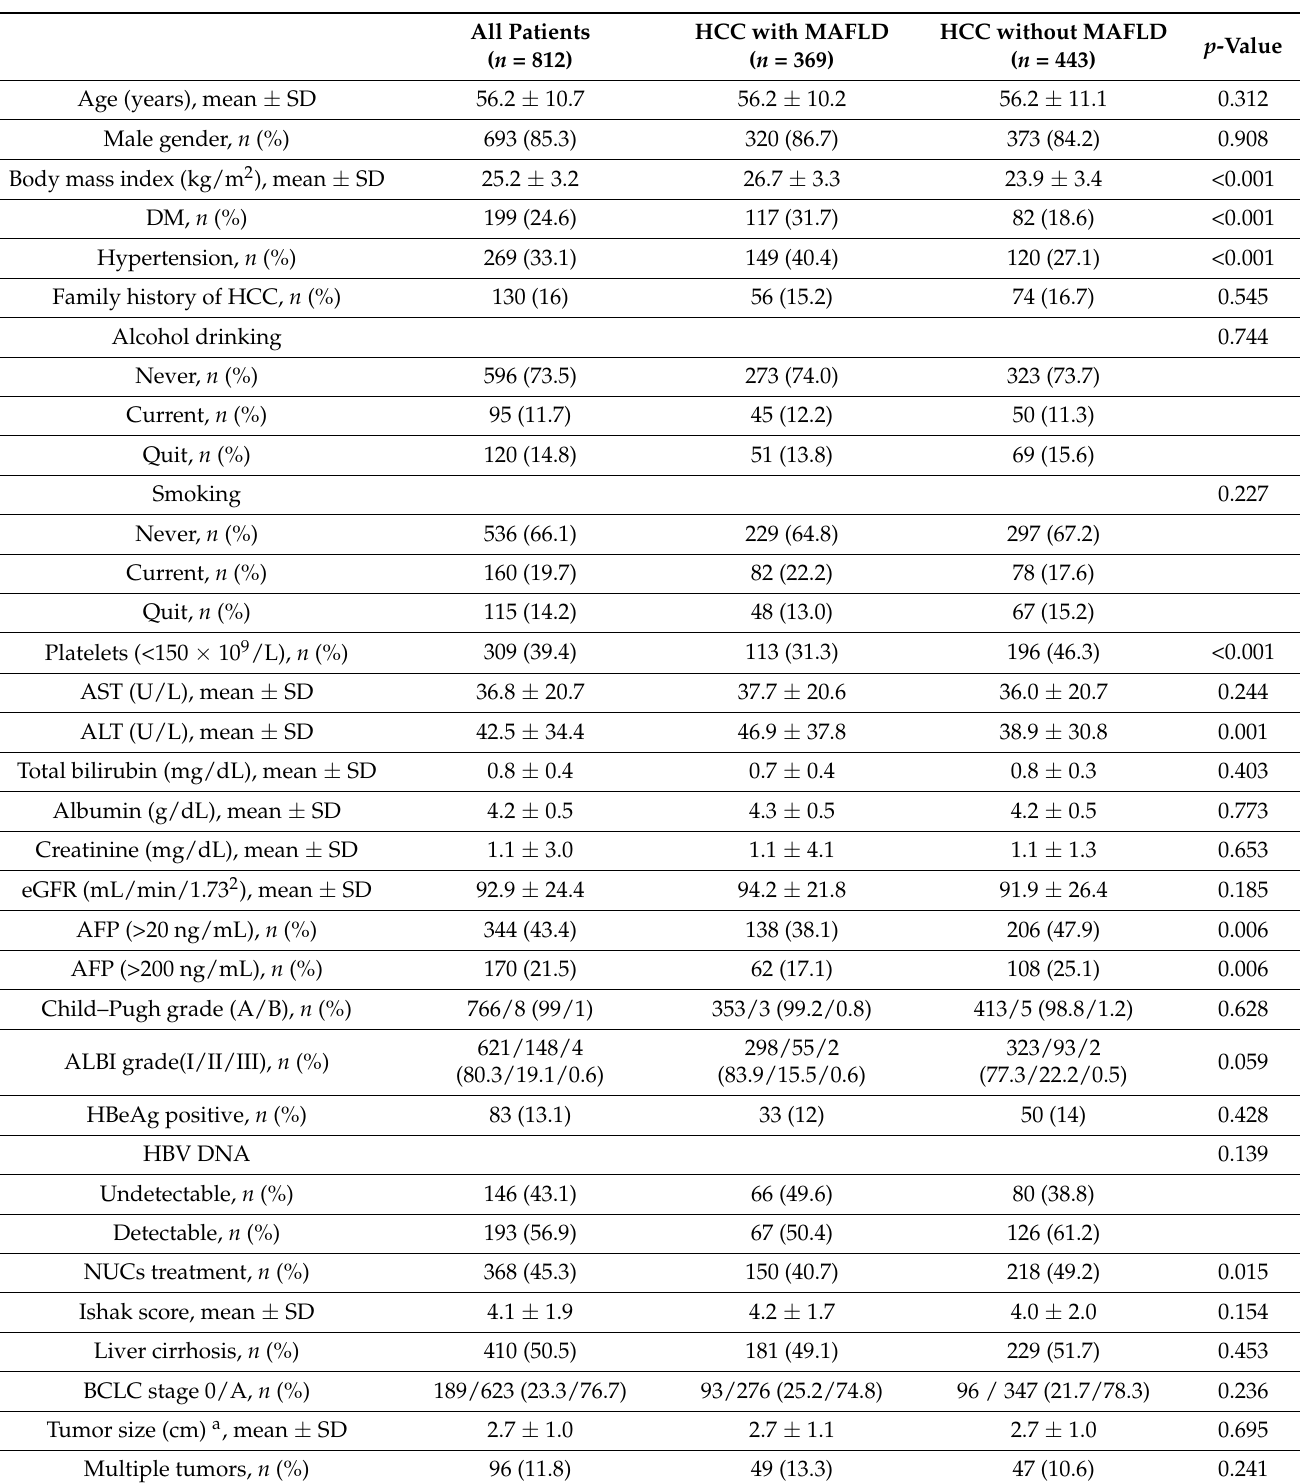
Table 1. Characteristics of the 812 patients with HBV-related early-stage HCC with or without MAFLD who underwent curative